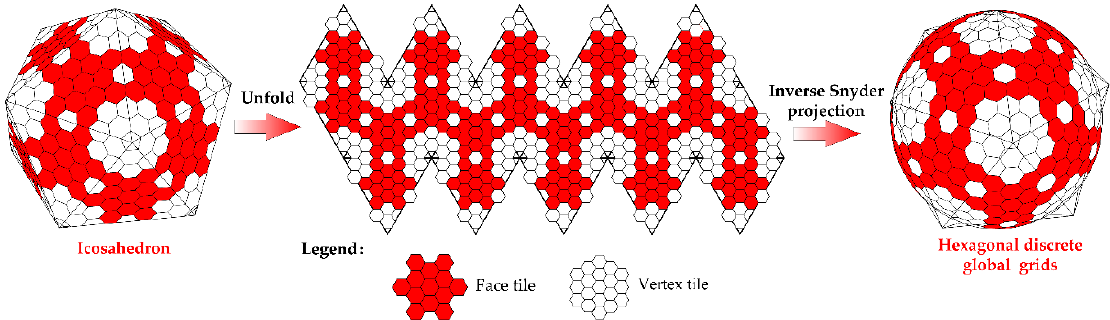
Figure 1. The icosahedral and spherical tile structure of the hexagonal lattice quad-tree structure (HLQT) encoding scheme.